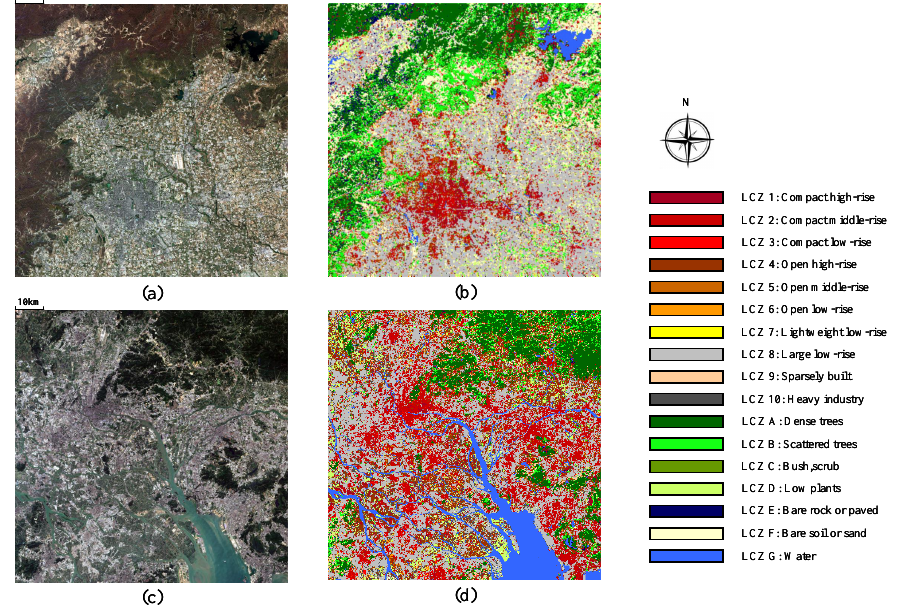
Figure 8. Two examples of large-scale LCZ classification, where ( a , b ) are the Sentinel-2 satellite image of Beijing, China and the corresponding LCZ map, and ( c , d ) are the Sentinel-2 satellite image of Guangzhou, China and the corresponding LCZ